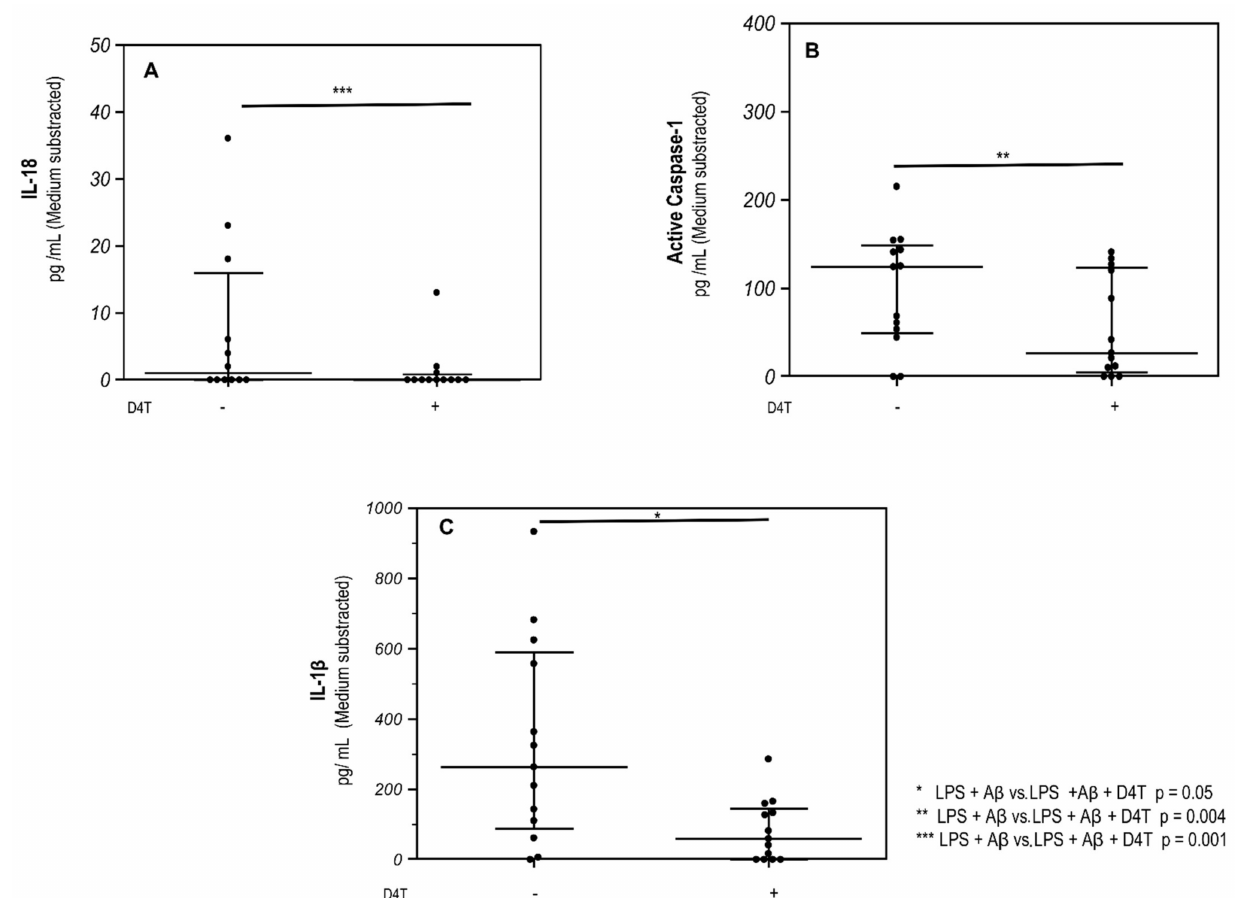
Figure 2. Caspase-1 and inflammasome effector cytokine production. Interleukin (IL)-1 β ( A ), Caspase- 1 ( B ) and IL-18 ( C ) production by LPS + A β -stimulated cells in the presence/absence of D4T were quantified by ELISA. Data are expressed as median cytokine and Caspase-1 concentrations (pg/mL) of stimulated cells with medium subtracted. Statistical significance is